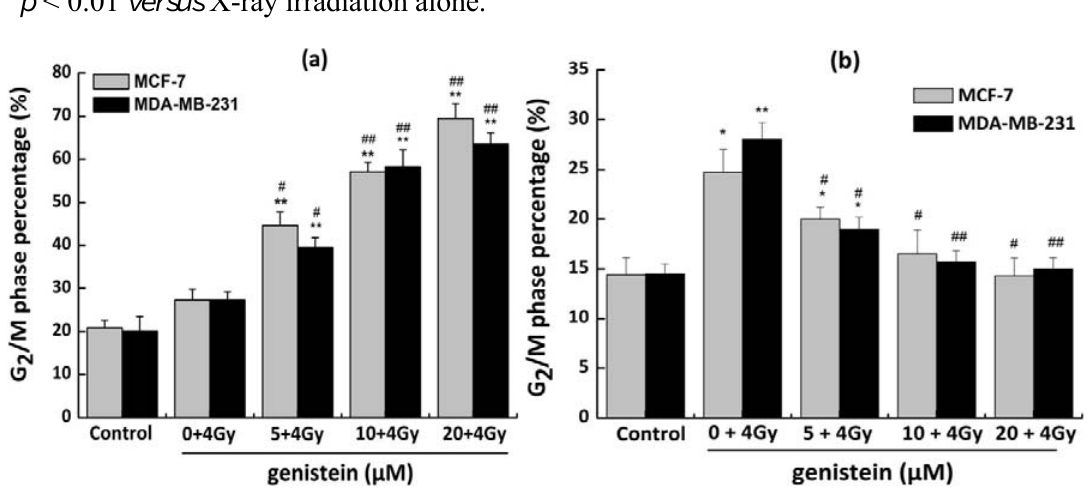
Figure 6. Effect of genistein combined with X-ray irradiation on the cell cycle distribution /M phase percentage at 12 h post-irradiation; of MCF-7 and MDA-MB-231 cells. (a) G 2 (b) G /M phase percentage at 24 h post-irradiation. All data are presented as means ± SD 2 from three independent experiments. * p < 0.05, ** p < 0.01 versus control group; # p < 0.05, ## p < 0.01 versus X-ray irradiation